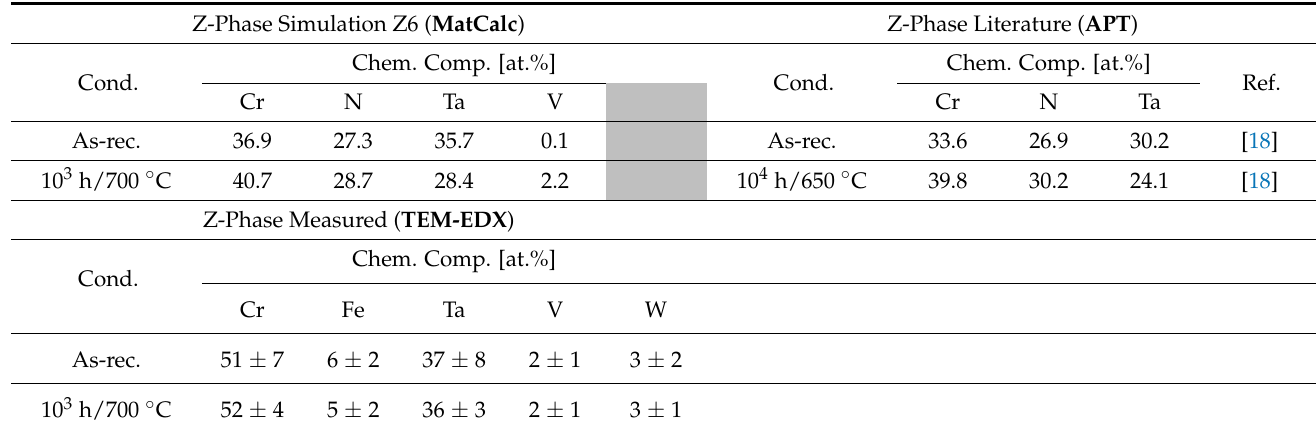
Chem. Comp. [at.%] Cond. Ref.